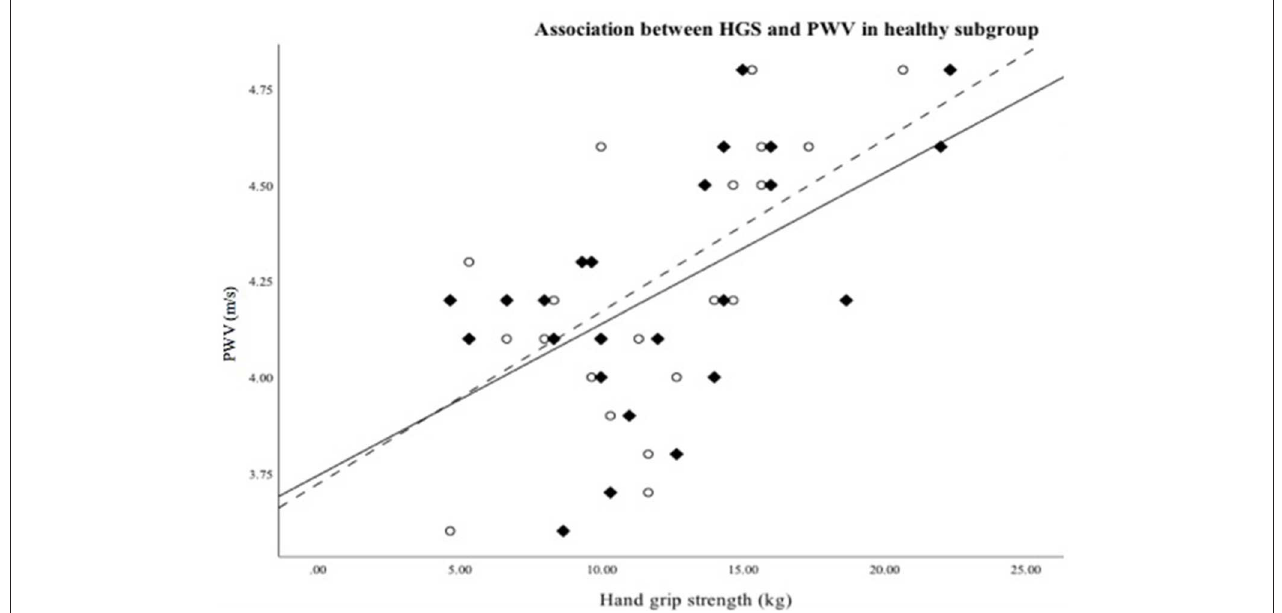
FIGURE 2 | Scatterplot showing association between hand grip strength right ( (cid:7) /—)/left (